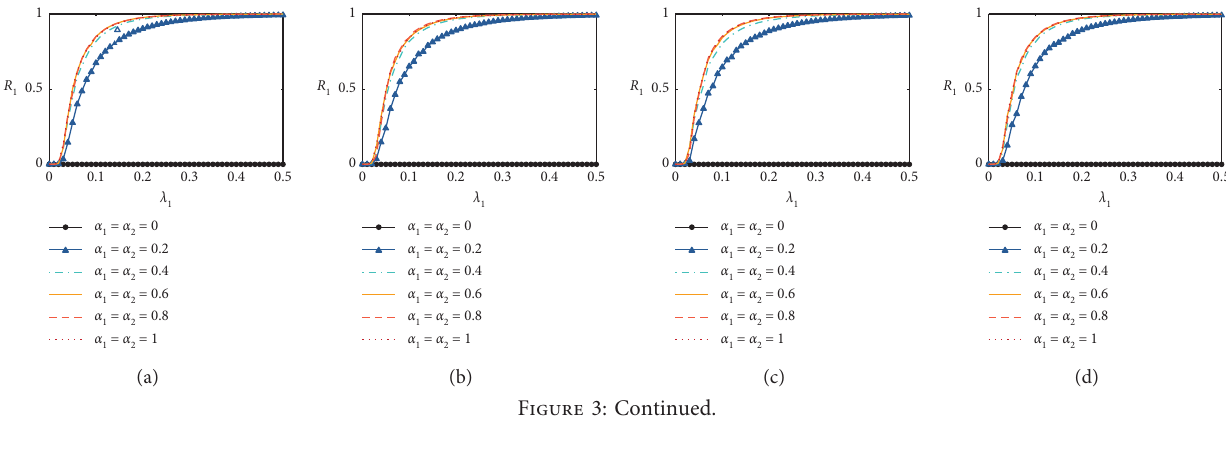
and information spreading size R versus computer virus transmission probability λ 1 2 � 0 . 4, (c) λ � 0 . 6, and (d) λ � 0 . 8. R versus λ with (e) λ 2 2 2 2 1 � c � 0 . 2 and λ � 0 . 1 2 2